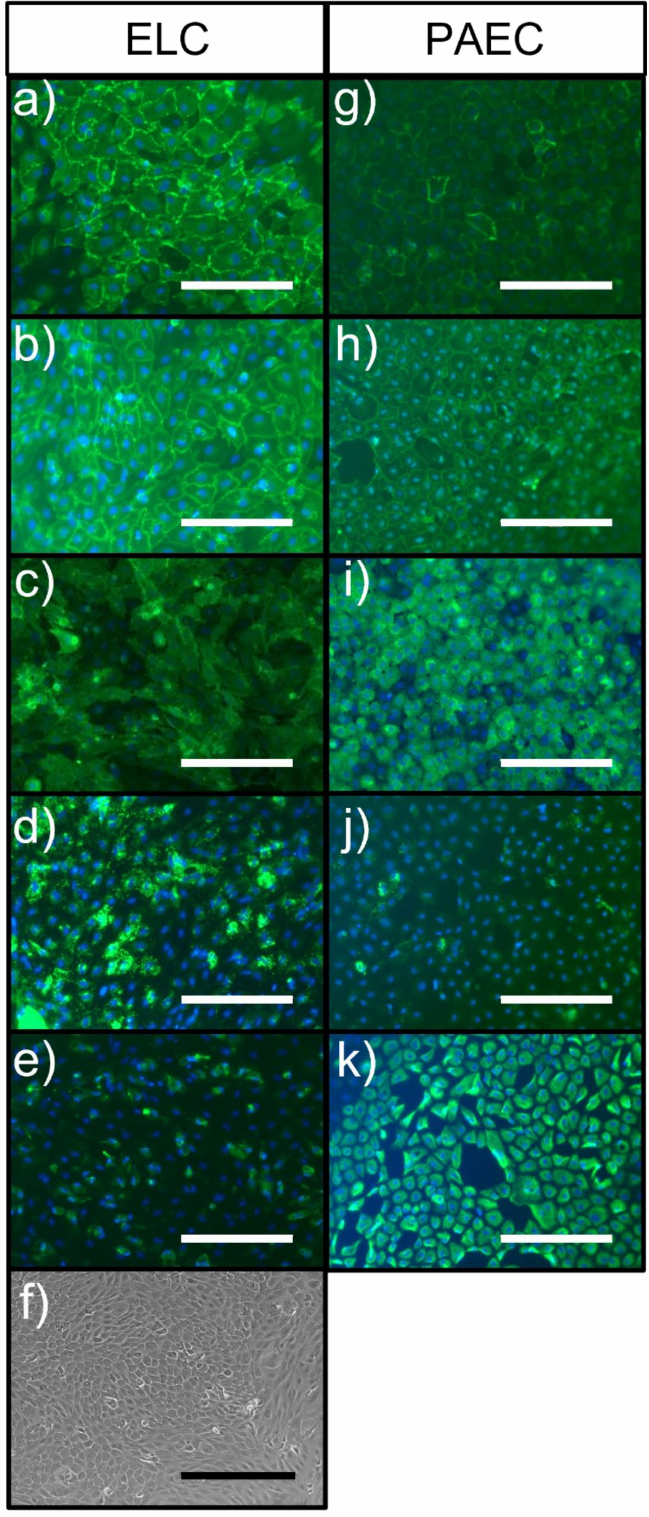
Figure 1. Representative images of porcine endothelial-like cells (ELC; ( a – e )) and porcine aortic endothelial cells (PAEC; ( g – k )) stained for common endothelial cell markers (green): CD31 ( a , g ), VE-Cadherin ( b , h ), DBA-Lectin ( c , i ), von Willebrand factor (vWF, ( d , j )), and vimentin ( e , k ); ( f ) phase contrast image of ELC showing cobblestone morphology. Markers of interest are shown in green. Nuclei are stained with DAPI (blue). White bars represent 200 µ m. The black bar in ( f ) represents 400 µ